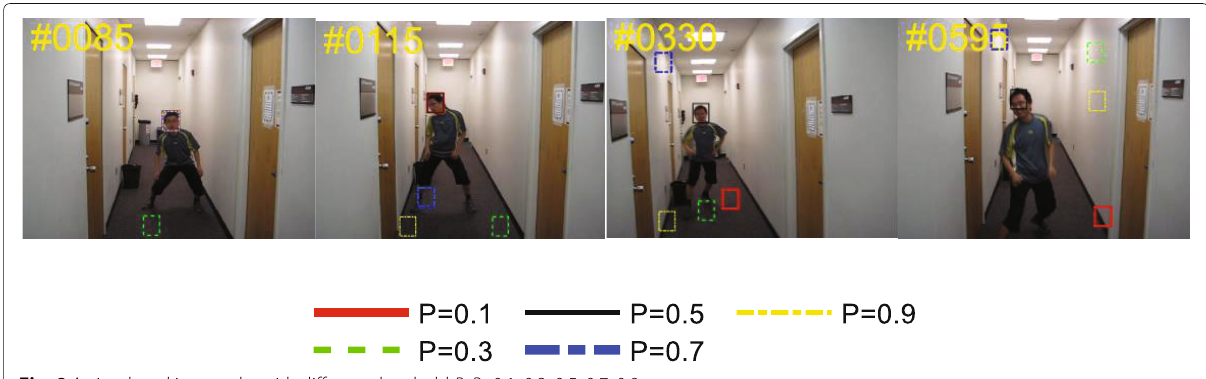
Fig. 8 A visual tracking results with different threshold P . P =0.1, 0.3, 0.5, 0.7, 0.9